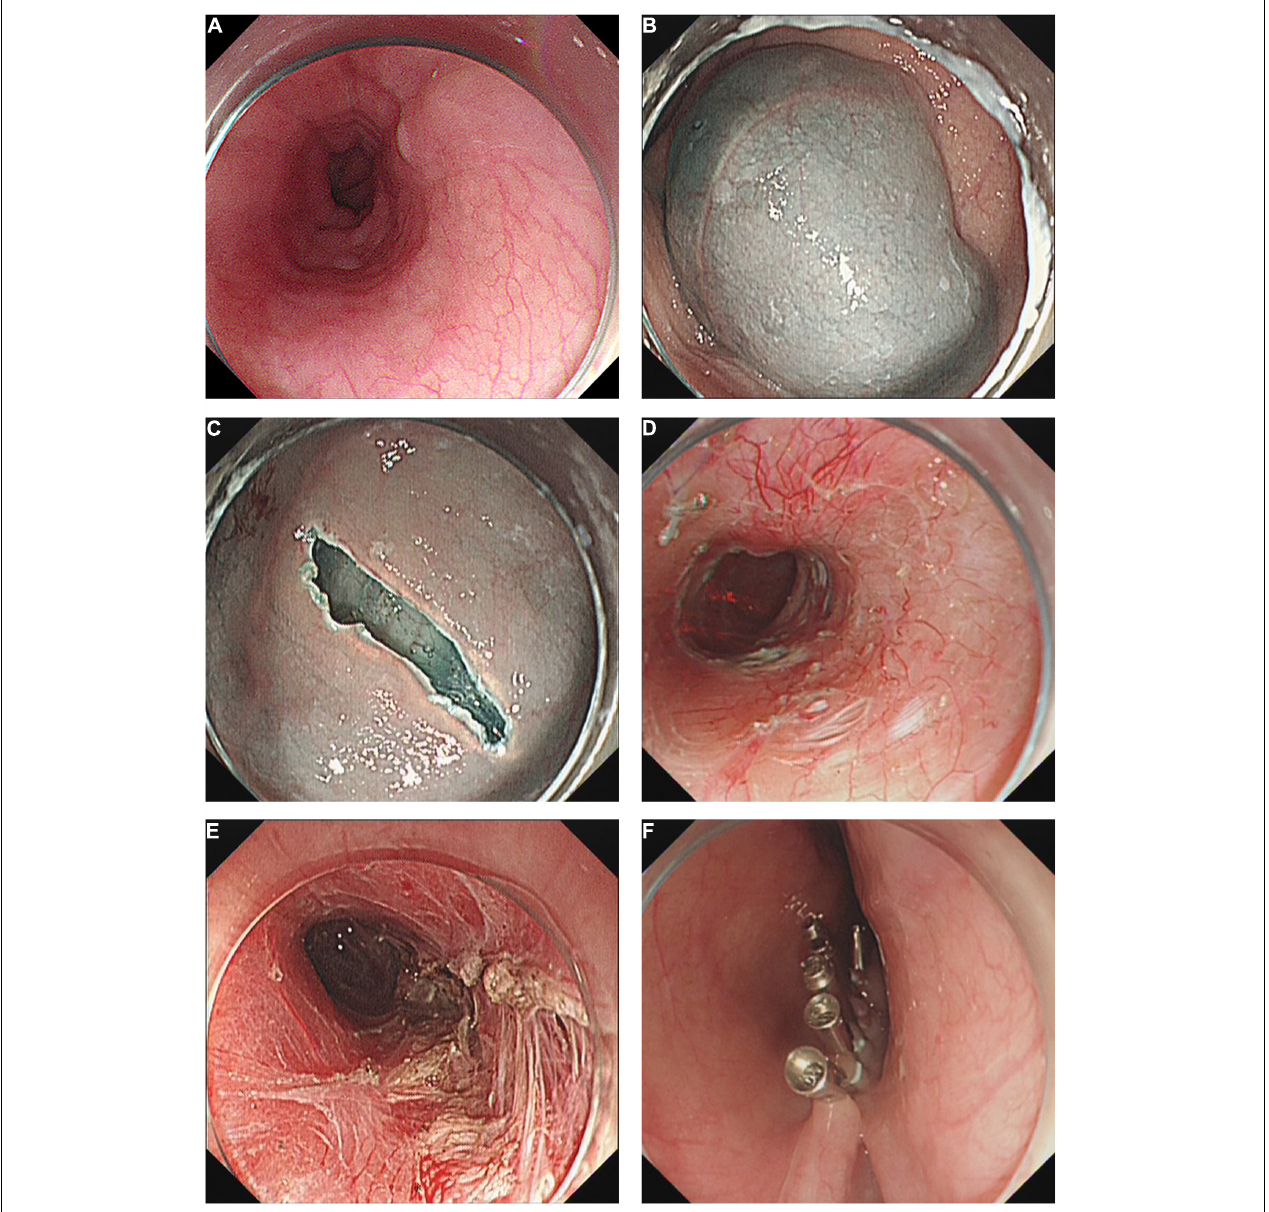
FIGURE 1 | Technique of peroral endoscopic myotomy. (A) A dilated esophagus. (B) Submucosal injection. (C) Create tunnel entry. (D) Submucosal tunnel. (E) Circular myotomy. (F) Close the tunnel entry with metal